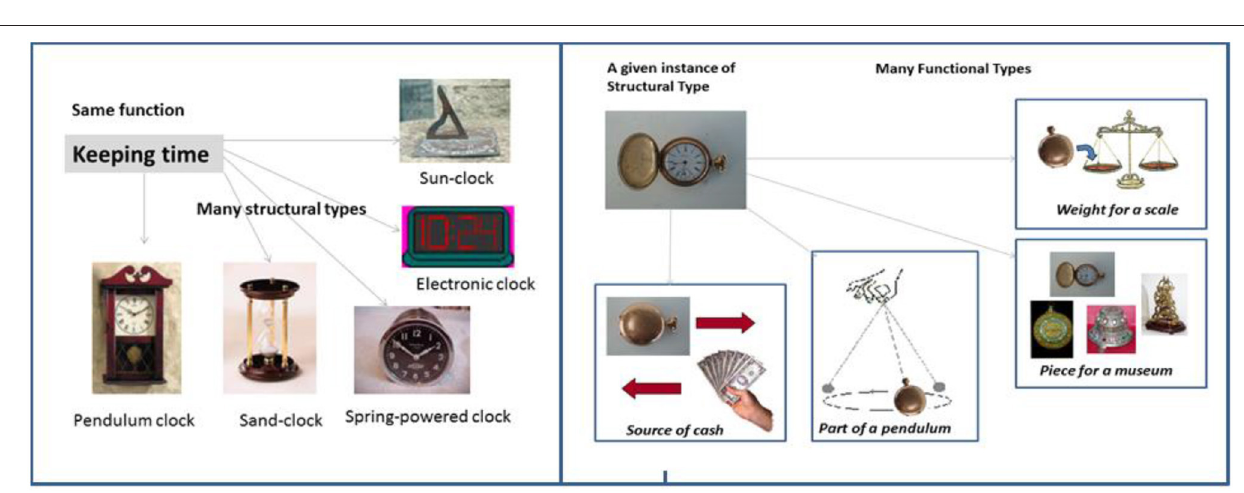
Frontiers in Energy Research |